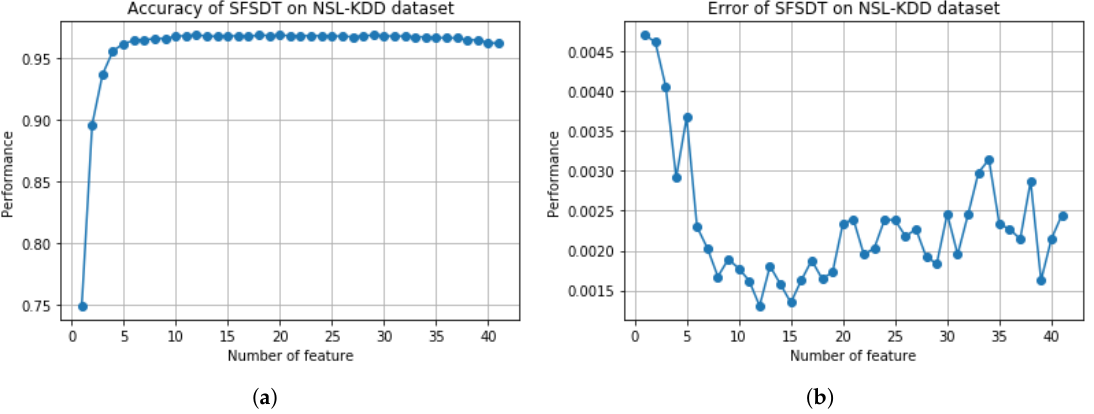
Figure 9. Visualization performance of SFSDT model on NSL-KDD dataset. ( a ) accuracy score & ( b ) error score.